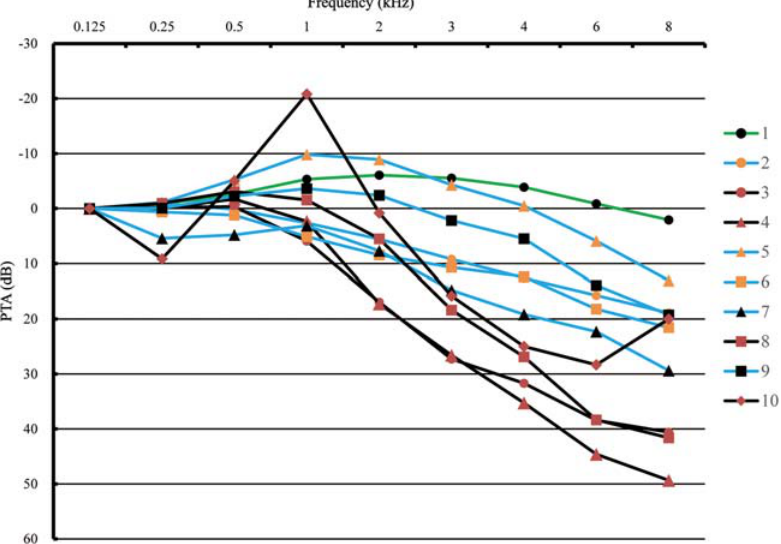
Figure 1: Ten audiogram patterns of hearing loss group classi fi ed by K - mean cluster analysis. All audiogram shapes are calibrated at 0.125 kHz for facilitating comparison. Hearing loss cases are divided into three subgroups: fl at shape ( line 1 ) , 2 – 4 kHz AL shape ( lines 3, 4, 8 and 10 ) and sloping shape ( lines 2, 5, 6, 7 and 9 )